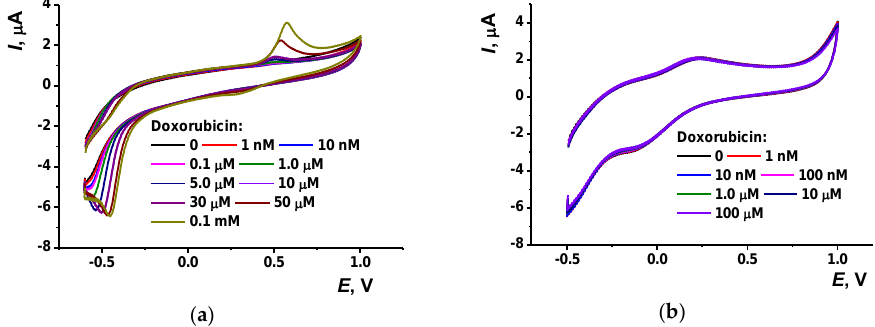
Figure 5. Cyclic voltammograms of doxorubicin recorded on glassy carbon, bare ( a ) and modified with copolymer of Azure B and proflavine ( b ). 0.025 M PB + 0.1 M KCl, pH = 7.0, scan rate 100 mV/s. With no modifier, an irreversible cathodic peak at −0.45 V and one irreversible anodic peak at 0.55 V appear on the voltammogram. They are regularly increasing with the doxorubicin concentration. However, after the electrode modification, doxorubicin does not affect the signals of